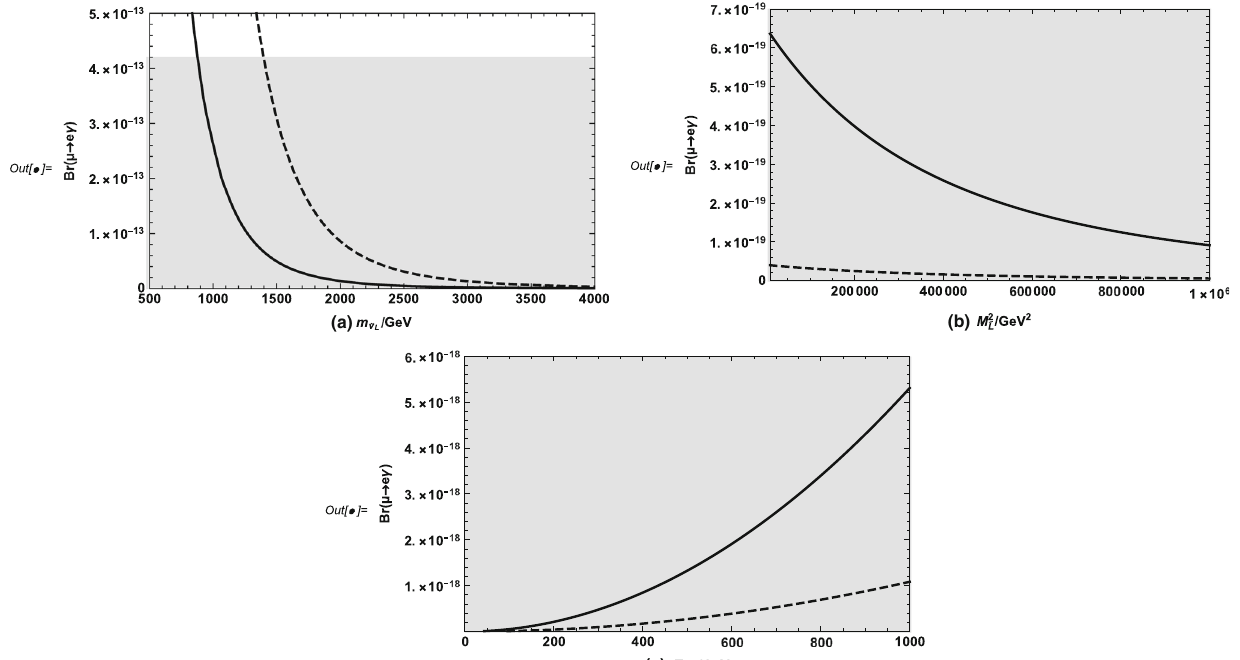
Fig. 7 Br (μ → e γ) schematic diagrams affected by different param- line and solid line respectively represent T e 12 = 50 GeV and 100 GeV = 5 × 10 5 TeV 2 , the dashed line (tan β = 9) and solid eters. The gray area is reasonable value range, where Br (μ → e γ) is in b . We set M 2 ˜ L lower than the upper limit. As T e 12 = 0, the dashed and solid lines in a line (tan β = 20) in c are = 500 GeV 2 and M 2 = 200 GeV 2 . The dashed correspond to M 2 ˜ ˜ L 12 L 12